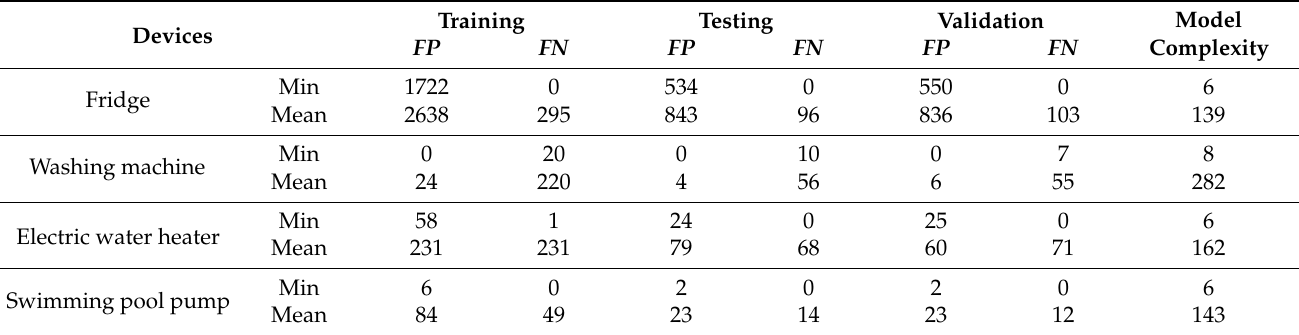
Table 5. Classification performance in the non-dominated